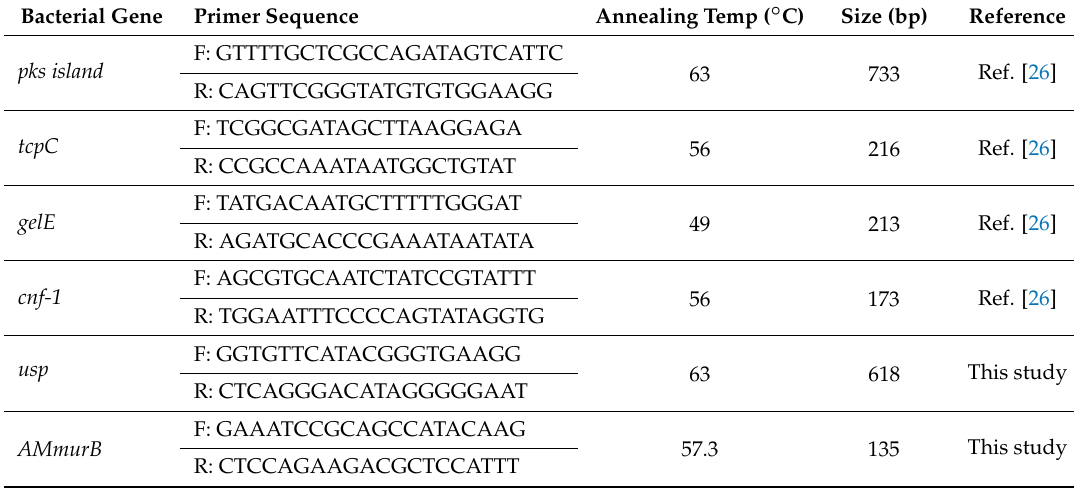
Table 2. Gut bacterial toxin gene primer sequences, annealing temperatures, and expected amplicon size for end-point PCR analyses.